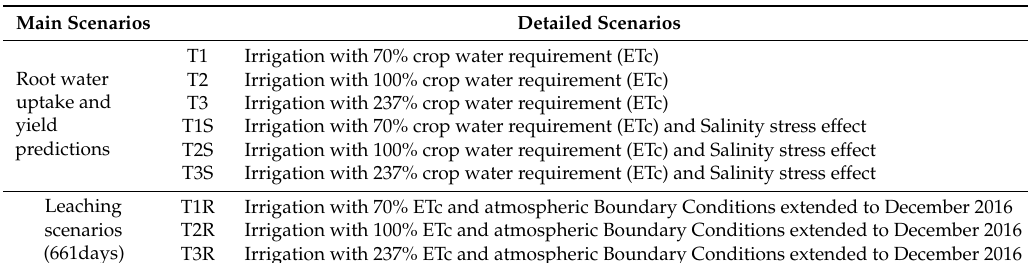
Table 2. Simulation